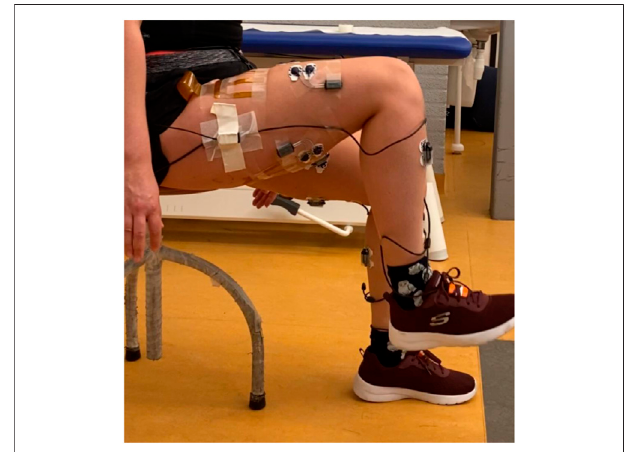
FIGURE 1 | Non-weight-bearing setup: subject is seated on a stool with one foot slightly lifted off the